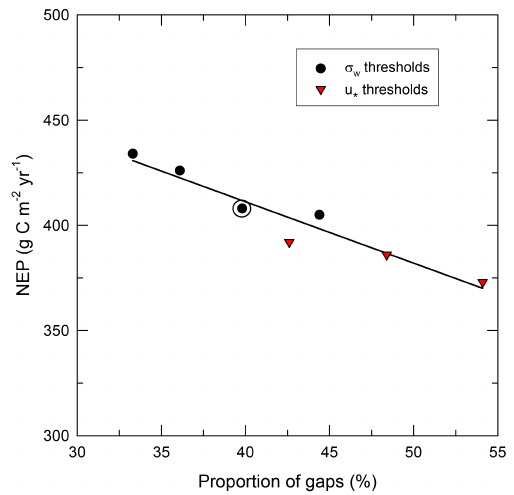
Figure 8. Variation of annual NEP estimate for the IFR pasture with the fraction of data gaps, as resulting from the choice of low- turbulence filter threshold. The σ w thresholds (dots) are, from left to right, 0.08, 0.10, 0.12 and 0.15ms − 1 ; the u ∗ thresholds (trian- gles) are 0.12, 0.15 and 0.18ms − 1 . The optimal threshold, based on moving-point threshold detection, is indicated by a circle. The solid line, obtained by linear regression, is displayed only to indicate the qualitative